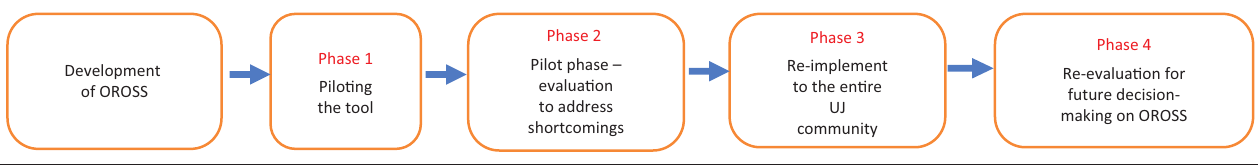
FIGURE 2: Online Research Output Submission System as a longitudinal